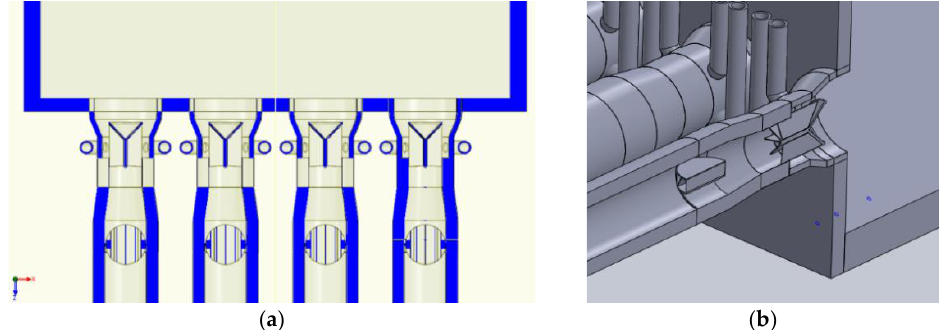
Figure 3. The SolidWorks model of stilling basin and Howell – Bunger valves: ( a ) top view with a schematic illustration of the section areas; and ( b ) details of the Howell – Bunger valve and butterfly valve in 3D Model.